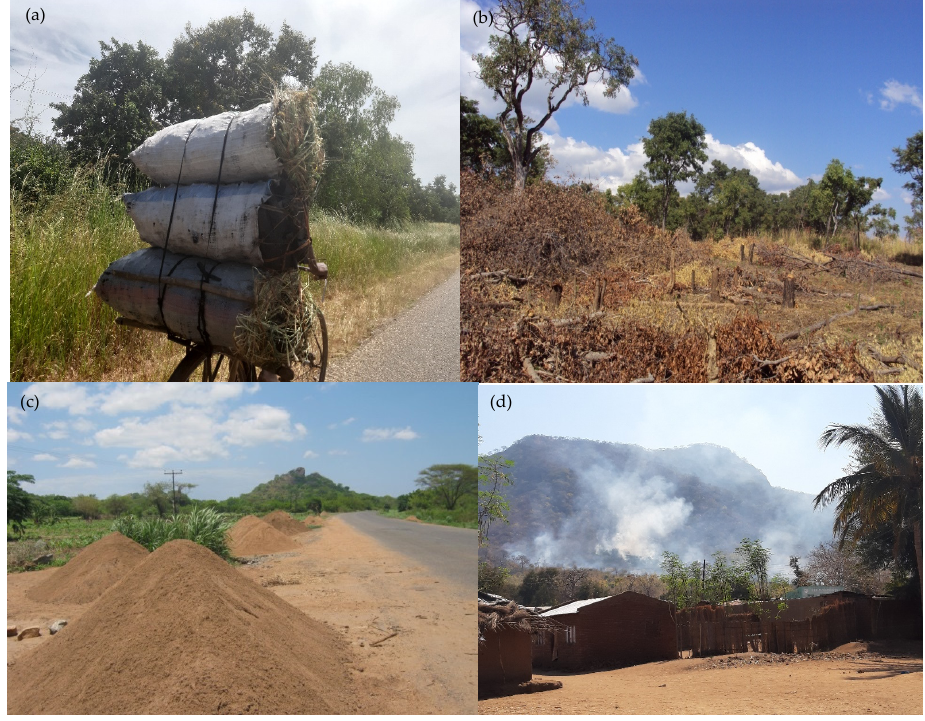
Figure 5. Pressure on the Lake Malombe ecosystem.